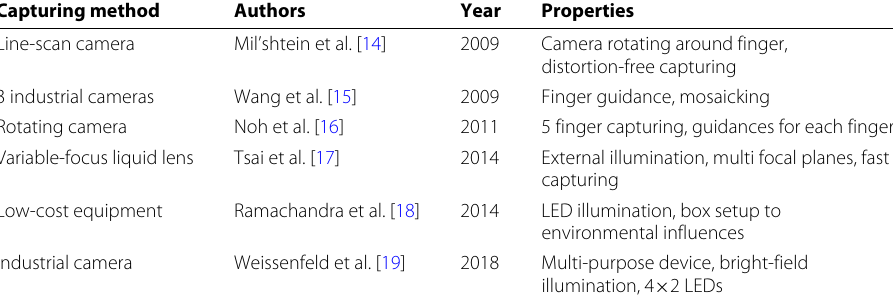
Table 1 Overview of most relevant prototypical hardware setups for capturing finger images Capturing